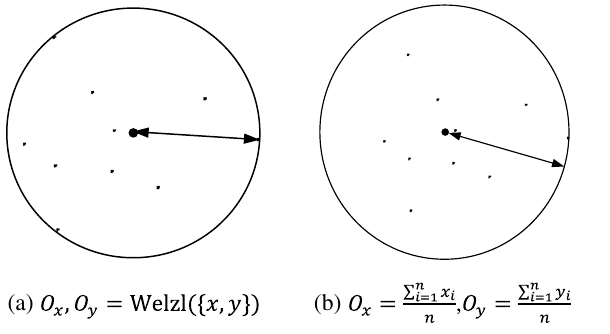
Figure 3. Schematic diagram of two area determination